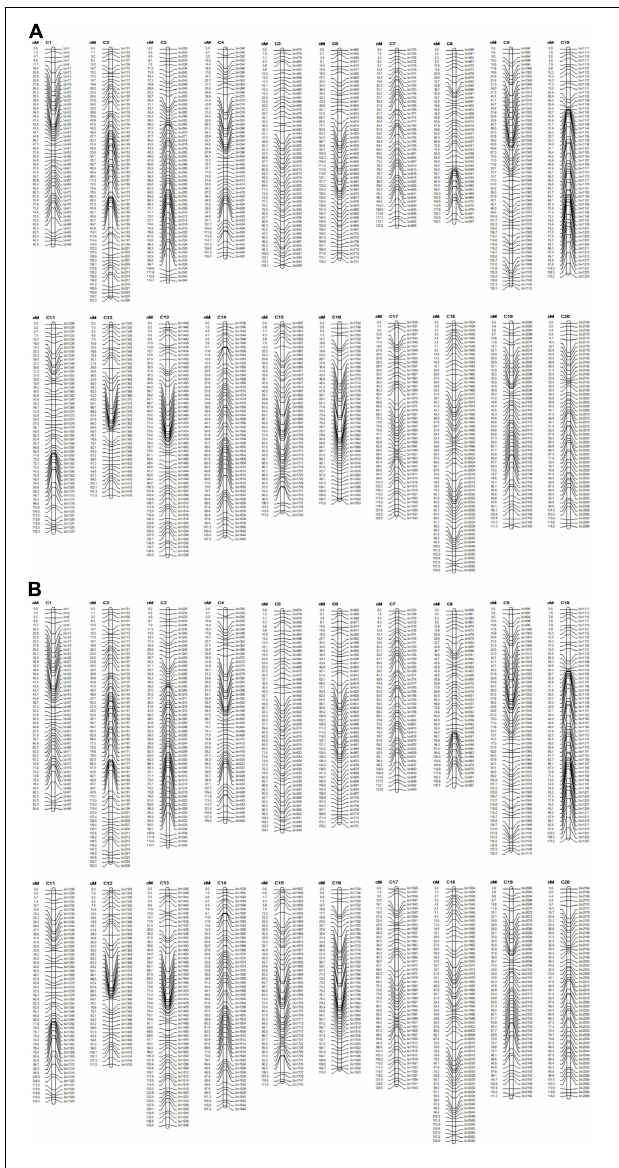
FIGURE 2 | The genetic linkage map of two soybean RIL populations. (A) The genetic linkage map for the LM6 population, and (B) the genetic linkage map for the ZM6 population. Map distances are shown in centimorgans